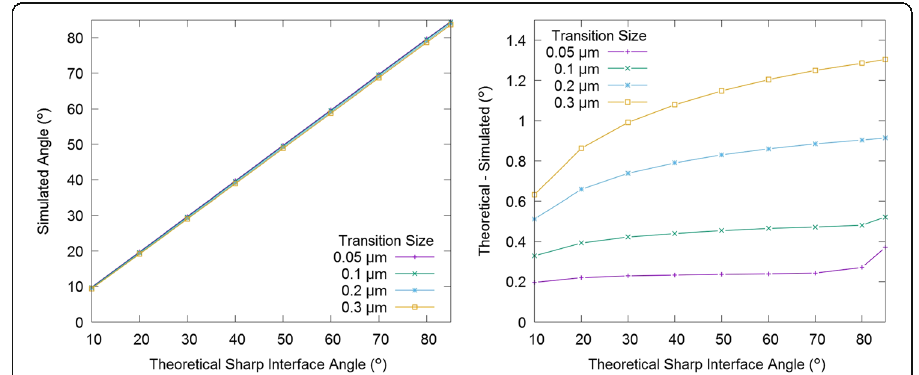
Fig. 9 Left : plot of contact angles calculated from the two-point method as a function of the theoretical sharp interface angle for the transition sizes between 0.05 and 0.3 μ m. Right : difference between the theoretical and simulated contact angles from the figure to the